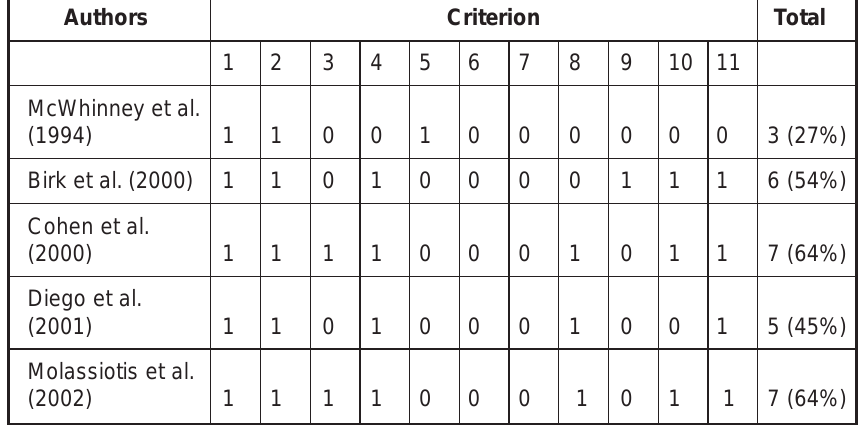
Table 9: Pedro Scale Results.